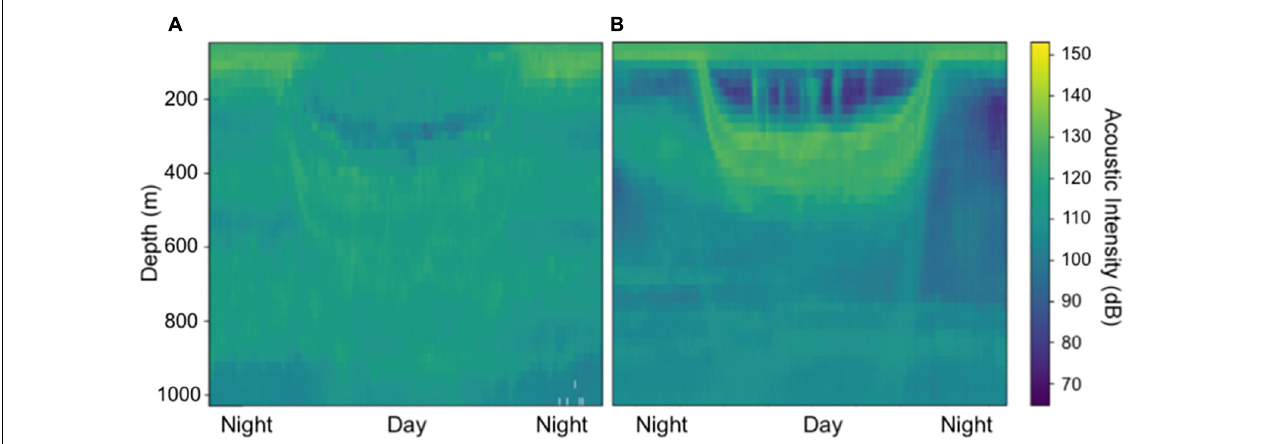
FIGURE 2 | Shipboard ADCP acoustic intensities at 38 kHz in (A) the northwest CCZ (16.31 ◦ N, 146.45 ◦ W) and (B) the eastern CCZ (11.89 ◦ N, 116.61 ◦ W) from November 2009. Acoustic intensity units are in decibels (RSSI counts*0.45).